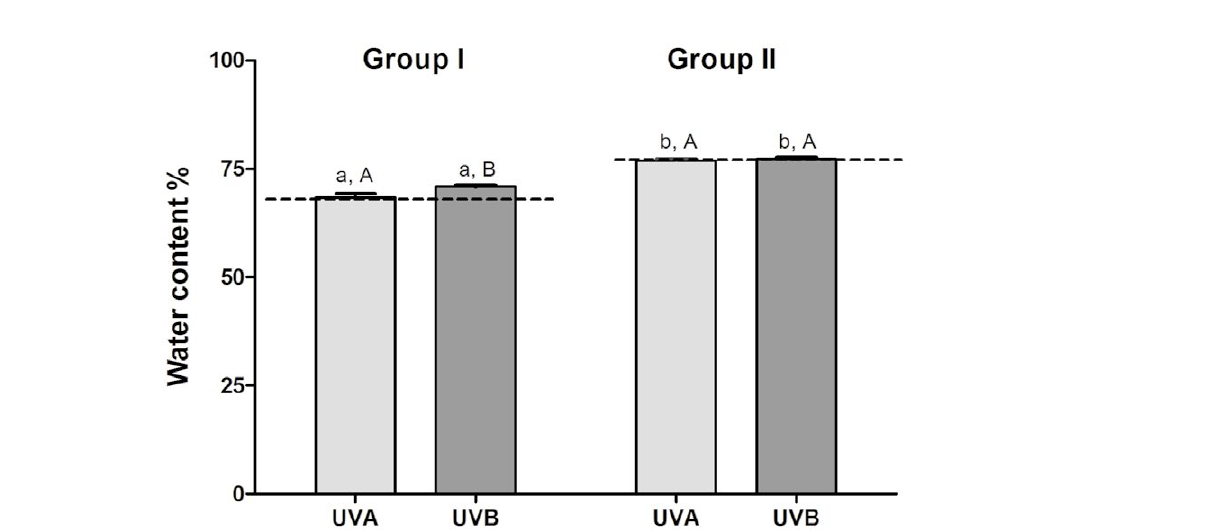
Figure 1. Percentages of water content of eggs of Macrobrachium olfersii from groups I and II following UVA and UVB exposure. Data are presented as the mean ± standard error of the mean (SEM). Dashed lines correspond to the percentage of water content of non-irradiated eggs from groups I and II. Lowercase letter indicates significant difference in each irradiation procedure between groups I and II. Uppercase letter indicates significant differences of the water content among irradiation procedures in the same